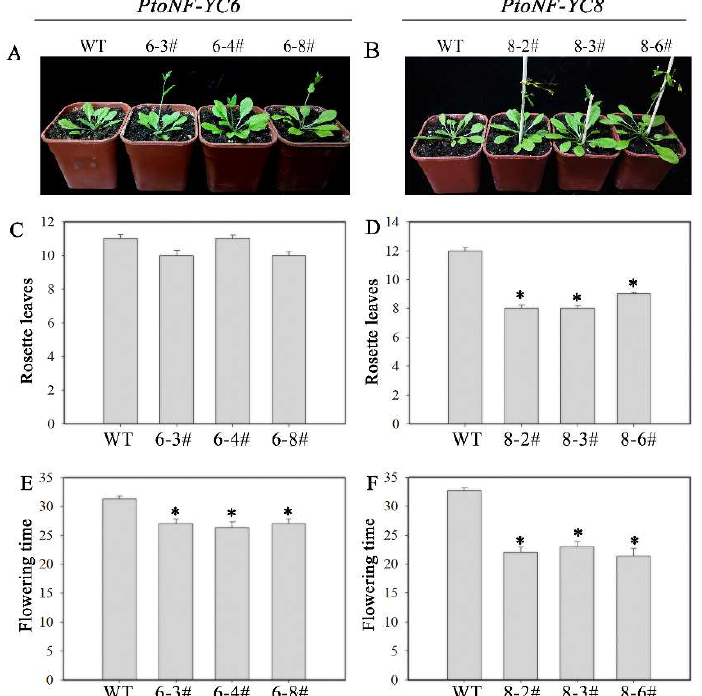
Figure 4. Flowering time and phenotype analysis of PtoNF - YC6 / 8 transgenic Arabidopsis . ( A , B ) Im- ages of flowering phenotype. ( C , D ) Analysis of rosette leaf number. ( E , F ) Analysis of flowering time. * ( p < 0.05) indicate significant differences.